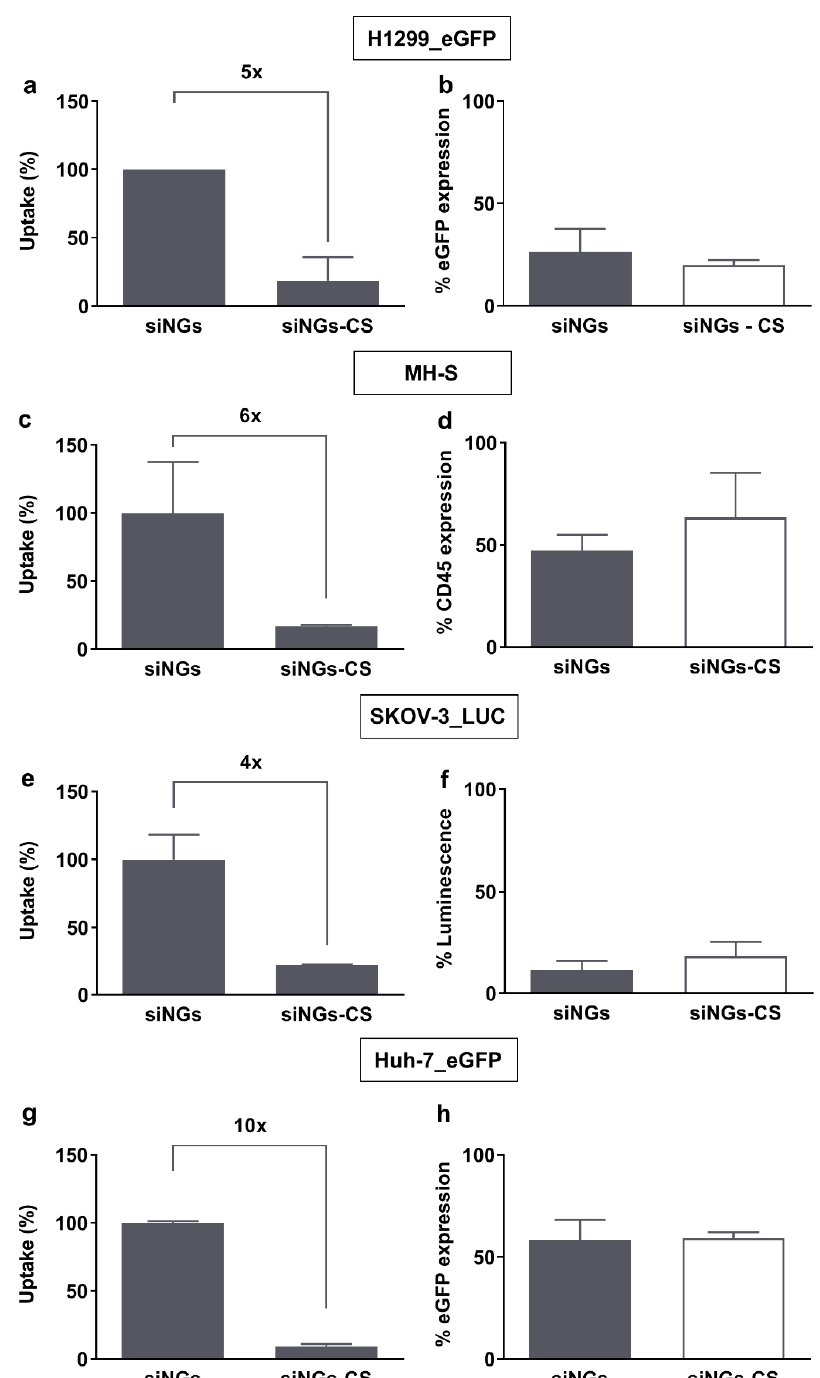
Figure 2. Biological e ffi cacy of surfactant-coated nanogels on (non-)pulmonary cell lines. ( a,c,e,g ) Flow cytometric quantification of cellular uptake of siCy5-loaded nanogels (siNGs) with and without Curosurf ® (CS) coating. ( b,d,f,h ) Gene silencing potential of siNGs and Curosurf ® - coated NGs (siNGs-CS). Despite the strongly reduced cellular uptake of siNGs following Curosurf ® coating, both formulations reach comparable levels of gene knockdown on the di ff erent cell lines studied. Experiments were performed with a fixed NG concentration (30 µ g / mL) and siRNA concentration (50 nM), except for the MH-S cell line, for which we used a final siRNA concentration of 100 nM. Experiments on H1299_eGFP and silencing of MH-S cell lines are the result of three independent biological repeats ( n = 3), other experiments are performed in technical triplicate.